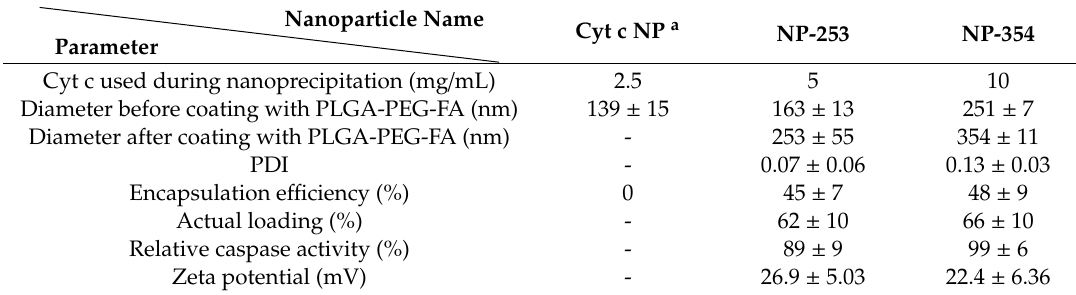
Table 4. Parameters of Cyt c-PLGA-PEG-FA NPs obtained using 5 mg / mL (NP-253) and 10 mg / mL (NP-354) Cyt c during nanoprecipitation. The same stoichiometries (molar ratios of Cyt c, crosslinker, and SH-PLGA-PEG-FA) were used in both cases b .